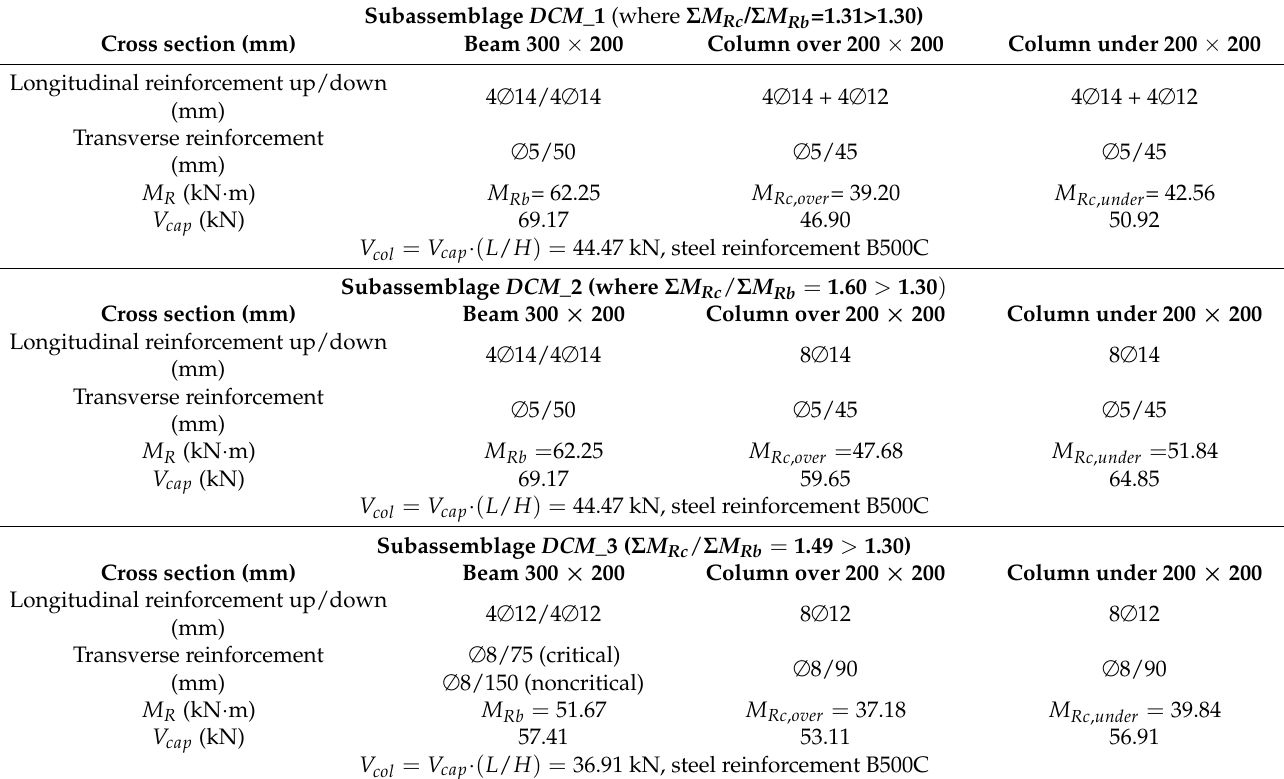
Table 1. Reinforcement, nominal flexural moment capacity, and shear capacity force of subassemblages designed according to EC2 and EC8 for DCM.